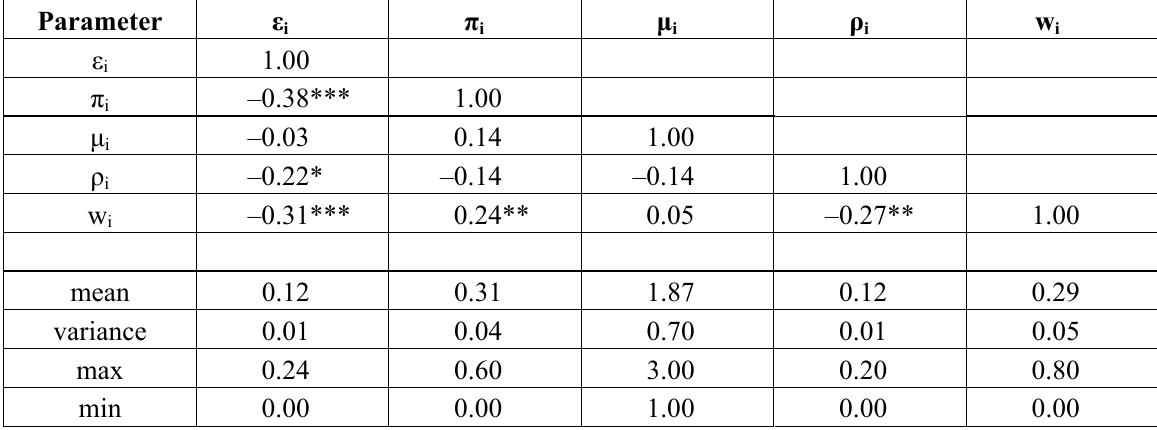
Table 2. Correlation coefficients and summary statistics for estimated trait